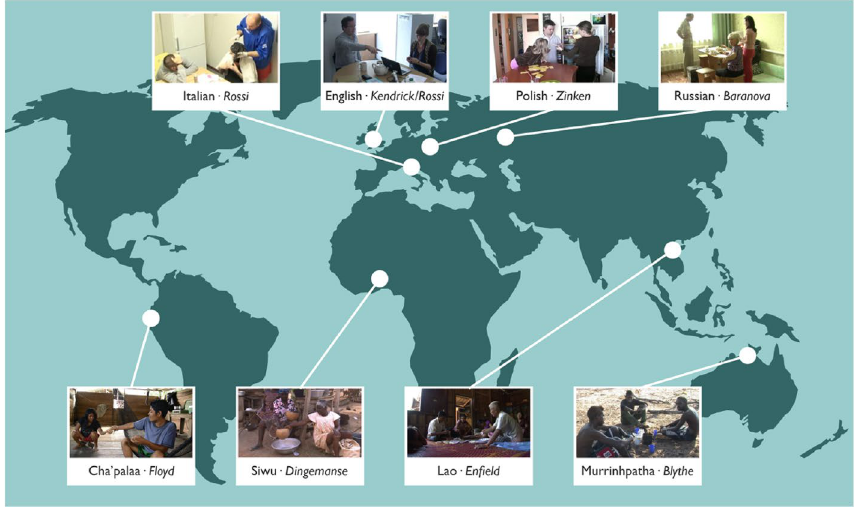
Figure 3. Locations of data collection. The map was created in CorelDRAW 2022 using a public-domain (CC0 1.0) vector file from Open Clipart (https:// openc lipart. org/ detail/ 1733/ world- map) and images from our video